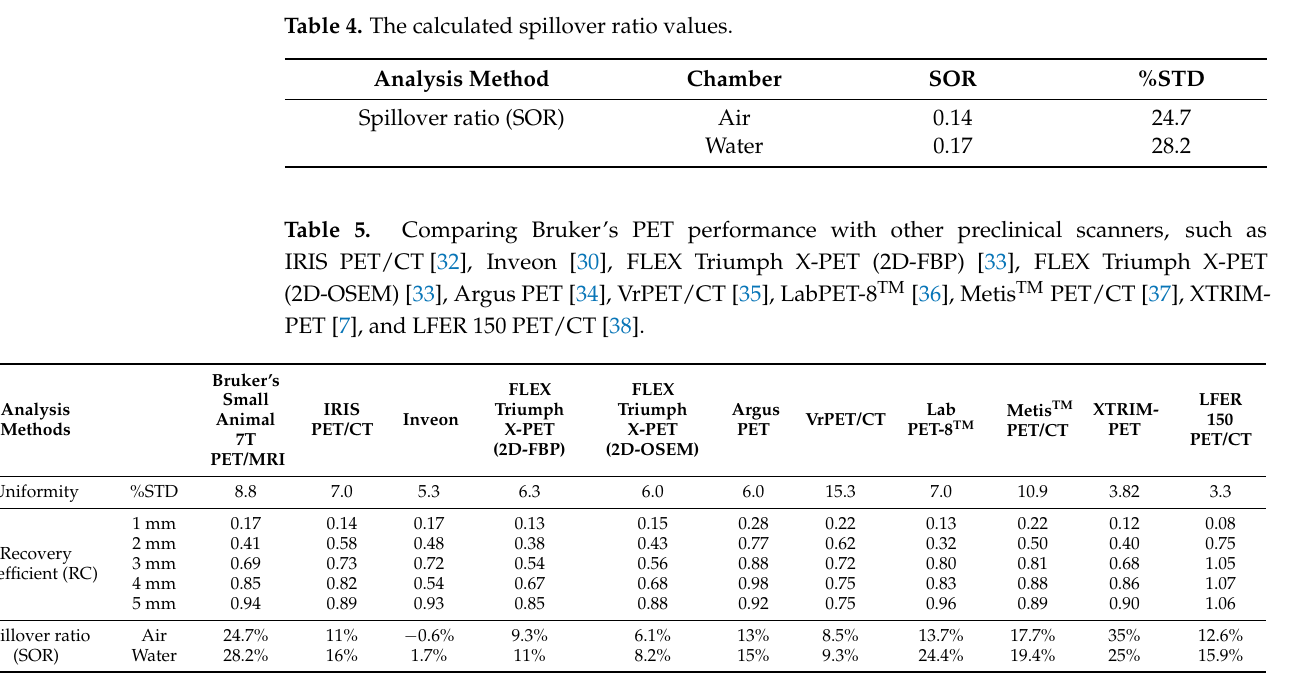
Table 4. The calculated spillover ratio values.